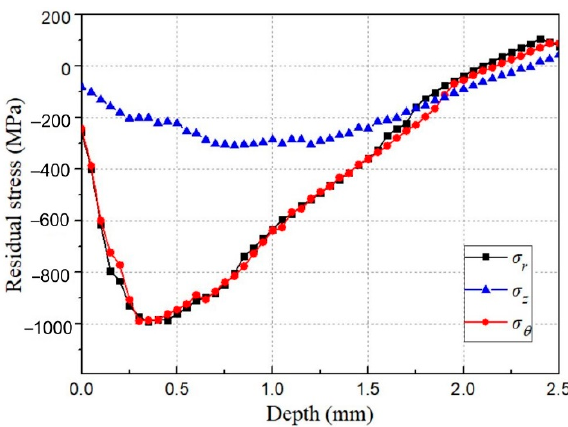
Figure 9. Distributions of the residual stresses along the depth in three directions.